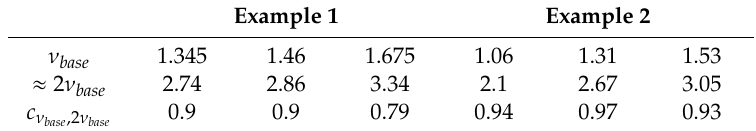
ν = 1.345, 1.46, base E t ) and at the inc and